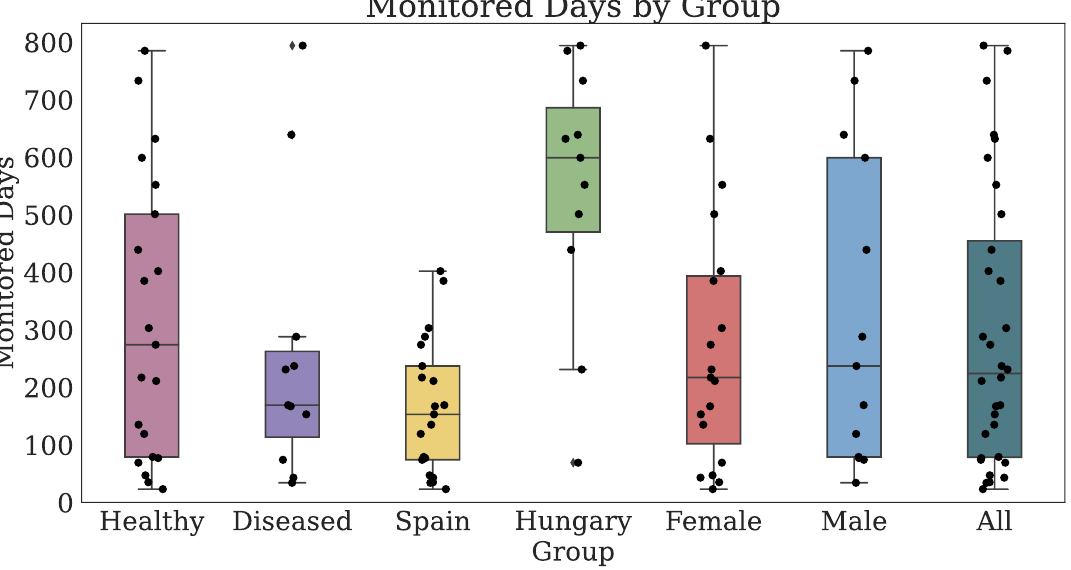
Figure 6. Days of Fitbit (TechRO) monitored days for seniors with at least one PRO.